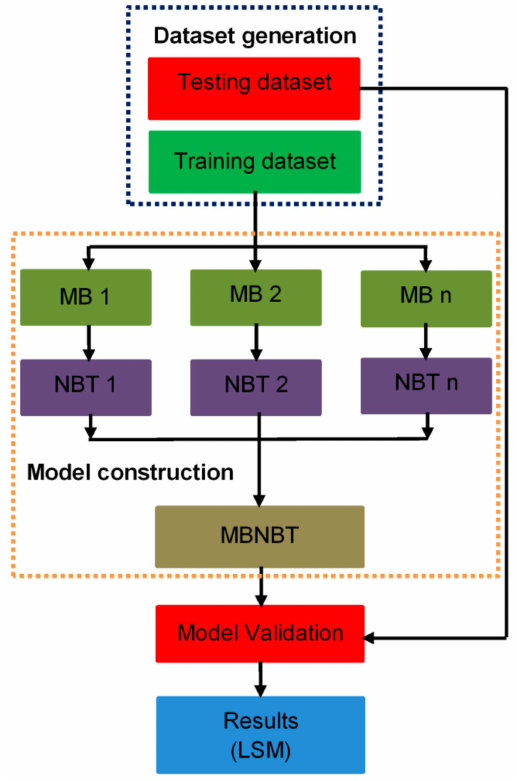
Figure 3. Methodology chart of the present